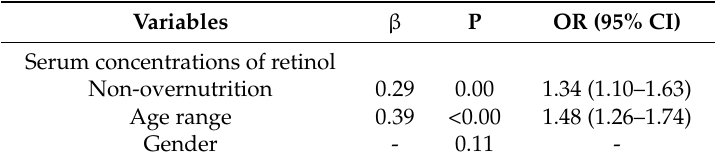
Table 3. Results of logistic regression for association of non-overnutrition, gender, and age range to inadequacy serum concentrations of retinol.